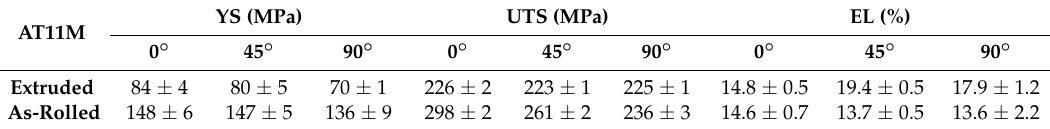
Figure 11. The curves of mechanical properties of sheets rolled at 250 °C and as-extruded. Table 3. Mechanical properties of as-rolled at 250 °C and as-extruded Mg-1Al-1Sn-Mn sheets.